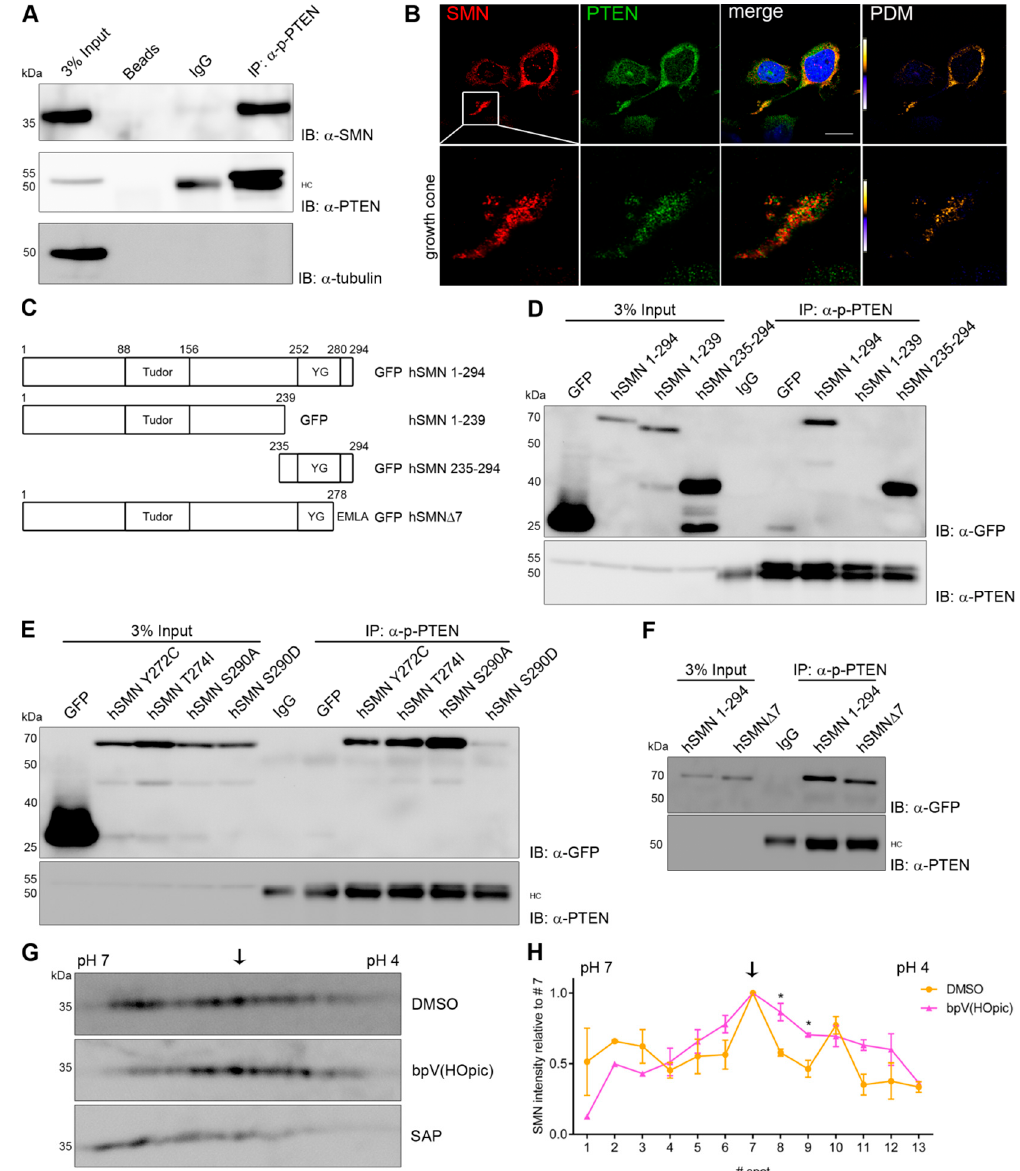
. Figure 4. Endogenous phosphatase and tensin homolog (PTEN) binds to the C-terminus of SMN and dephosphorylates SMN. ( A ) Co-immunoprecipitation of endogenous p-PTEN and SMN from lysates of di ff erentiated NSC34 cells. Beads alone, IgG and tubulin were used as negative controls. HC represents heavy chain. ( B ) Confocal images of NSC34 cells were stained for endogenous SMN and PTEN together with their respective PDM images. Scale bar represents 20 µ m. ( C ) Schematic overview of hSMN constructs used in immunoprecipitation assays. Cells were transfected and prepared for the assay 18 h post-transfection. ( D – F ) Co-immunoprecipitation assays with hSMN deletion constructs ( D ), patient mutations ( E ) and SMN ∆ 7 ( F ) 18 h post-transfection. ( G , H ) Isoelectric focusing of SMN from NSC34 cells treated with either DMSO, PTEN inhibitor bpV(HOpic) or shrimp alkaline phosphatase (SAP) for 2 h prior to lysis. Spot #7 (indicated by arrow) was used as reference (mean ± SEM, n = 3, paired two-tailed t-test, * p <